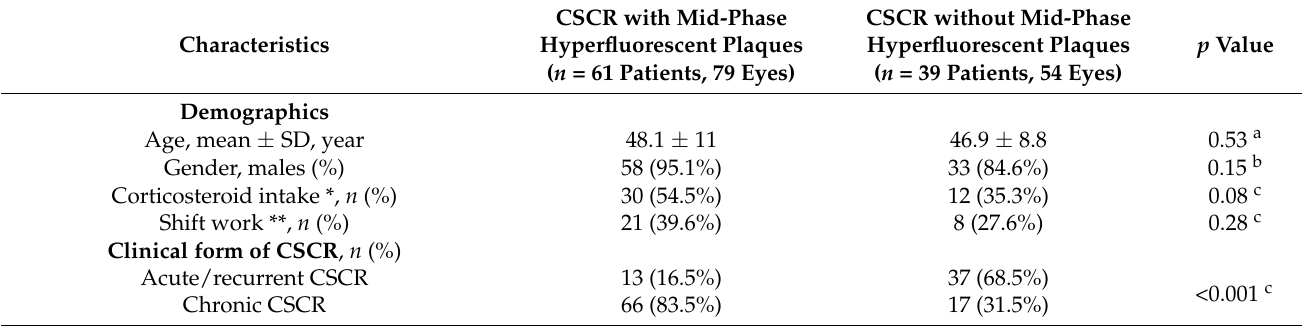
Table 2. Comparison between Eyes with and without Mid-phase Hyperfluorescent Plaques on Indocyanine Green Angiog-